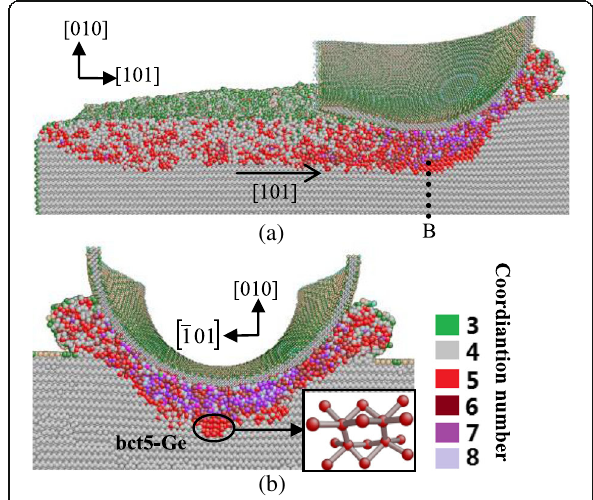
Fig. 7 Cross-sectional views of the subsurface deformation when nano-cutting along the [101] direction on the (010) plane. a On the (cid:4) (cid:5) plane, passing along the [101] direction through the middle 101 of the tool. b On the (101) plane, passing through B